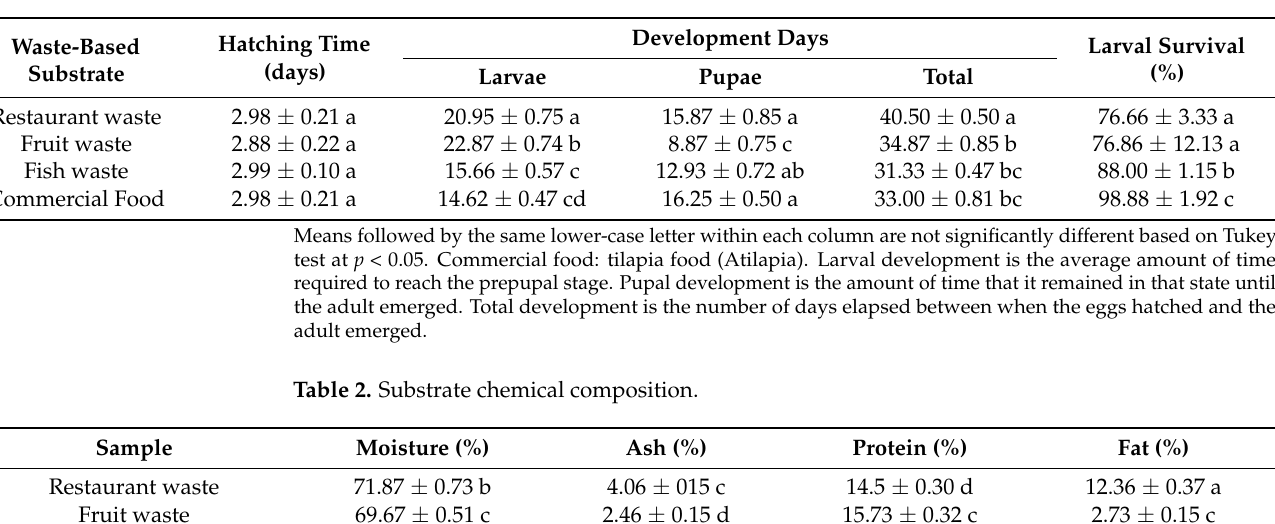
Table 1. Survival (%) and development (days) of BSFs reared on diverse food-waste-based substrates.